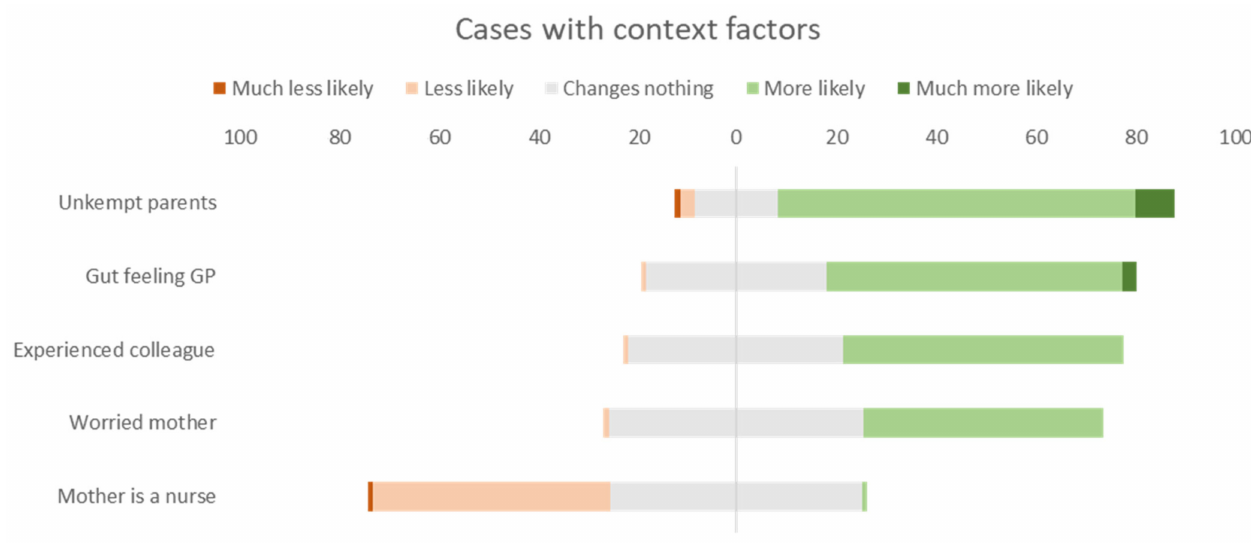
Figure 2. Overall answers to cases with non-medical factors in